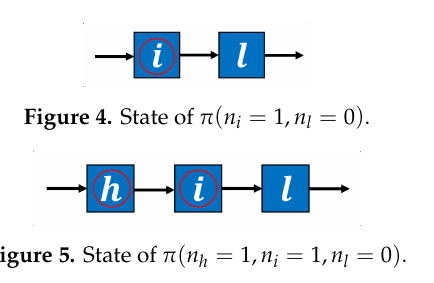
Figure 5. State of π ( n h = 1, n i = 1, n l = 0 )